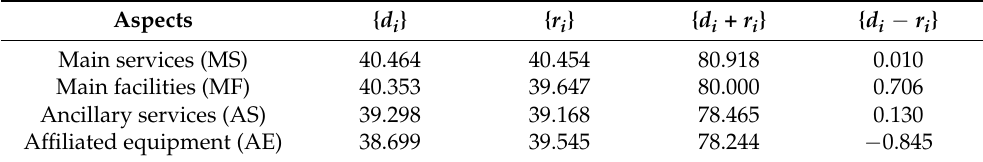
Table 7. The degree of full influence.